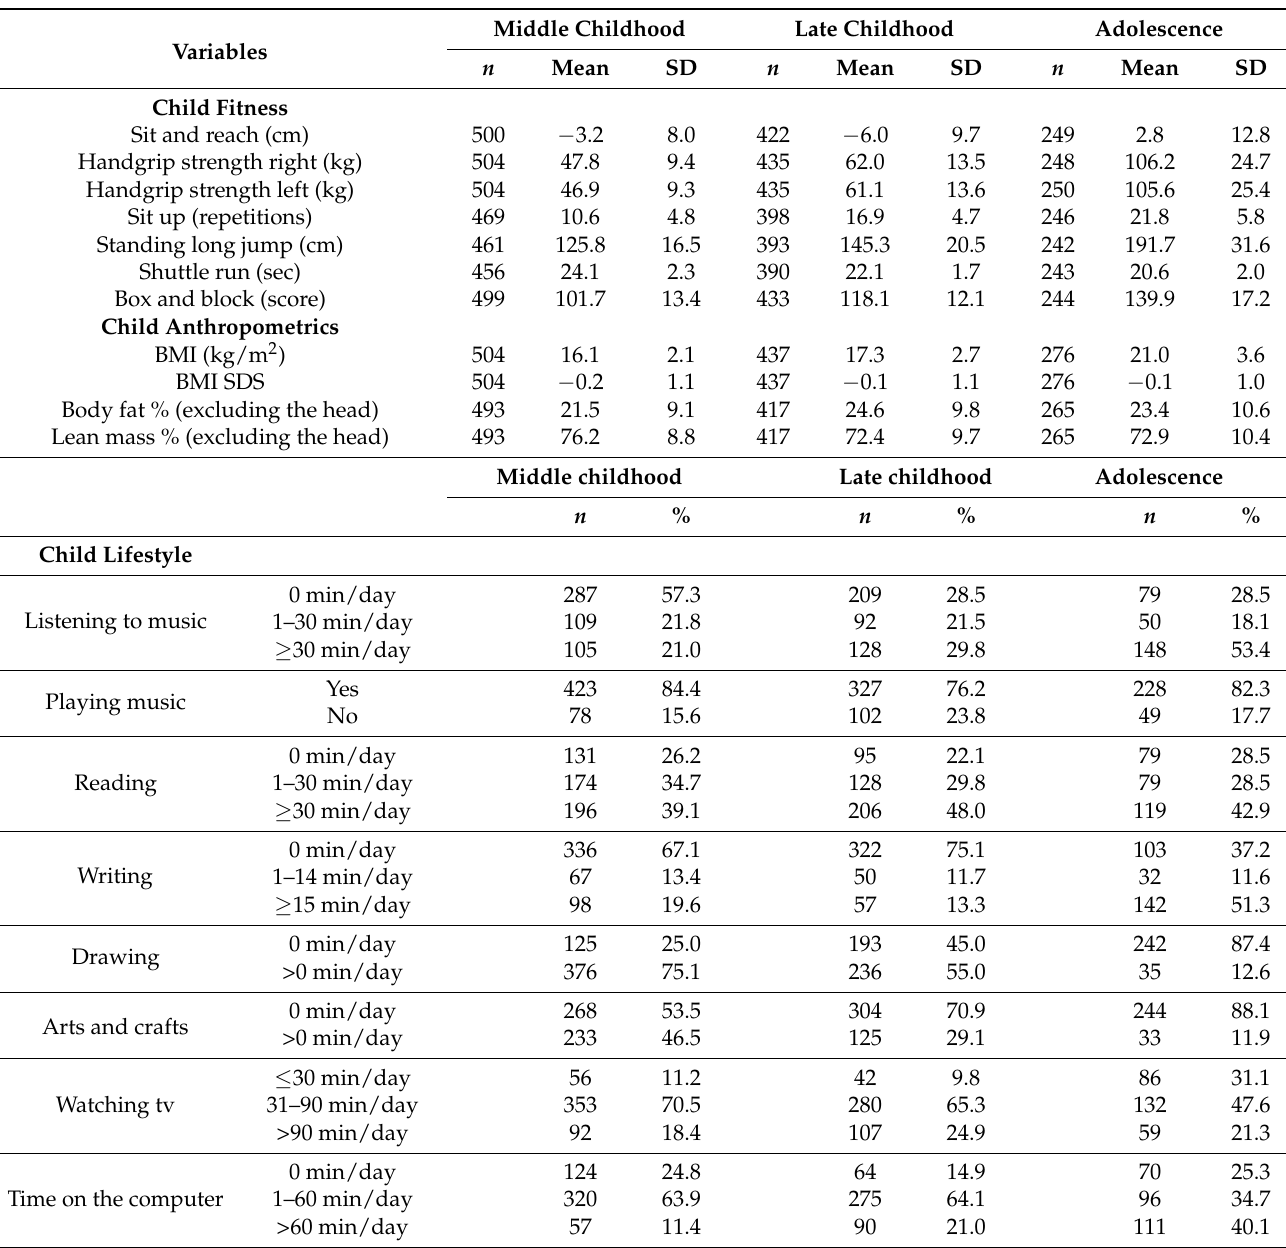
Table 2. Descriptive data on child’s fitness, anthropometrics and lifestyle at middle childhood, late childhood and